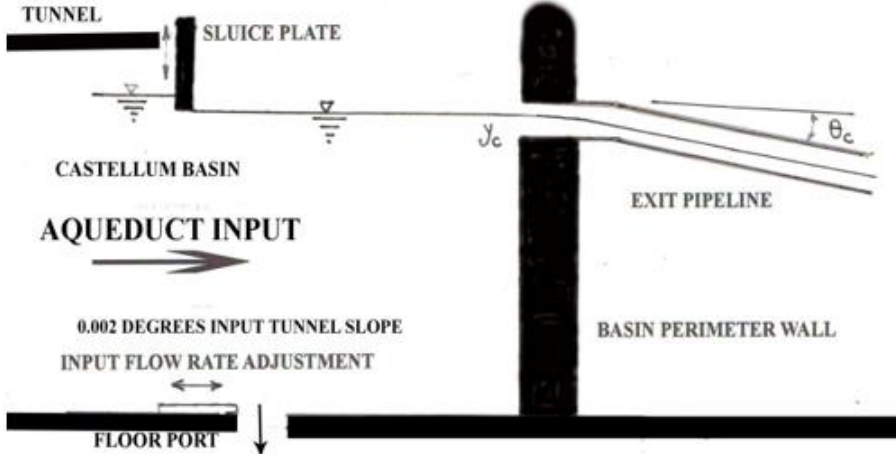
Figure 41. The Roman design of the Pont du Gard castellum (not to scale). Results from [2], p. 310.